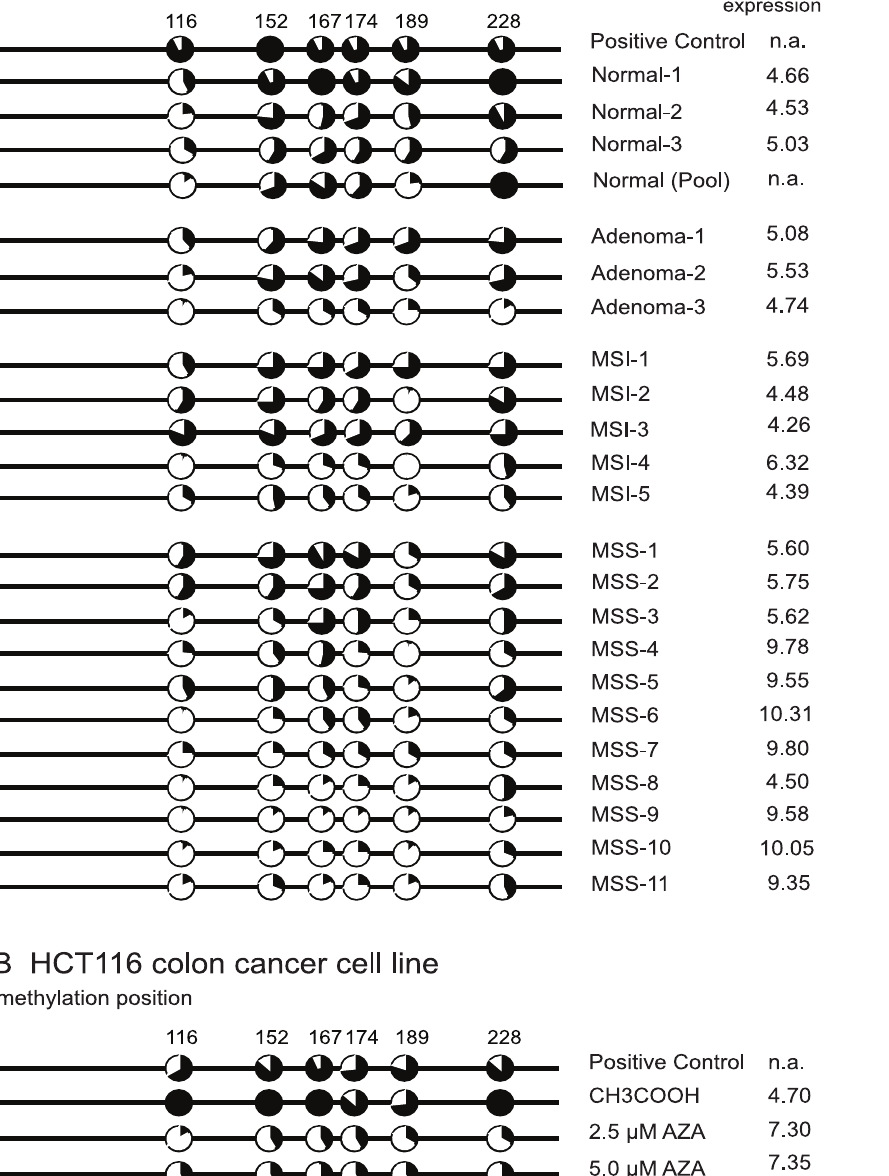
Figure 2. Bisulfite sequencing of colon tissues and HCT116 cells six positions. Position 116 corresponds to Cg22392708. unmethylated; MSI and MSS colon adenocarcinomas. A) Methylation status of colon biopsies was compared to transcript expression data from Exon 1.0 ST arrays. For the majority of samples, high methylation values are in agreement with low expression values and vice versa. Log2 intensities are shown in the panel on the right, values below log2=5 were regarded as absent expression. B) Treatment of HCT116 cells (MSI) not expressing KRT23 with 5 9 -AZA-dC showed that decreased methylation resulted in an increased expression of the KRT23 transcript.